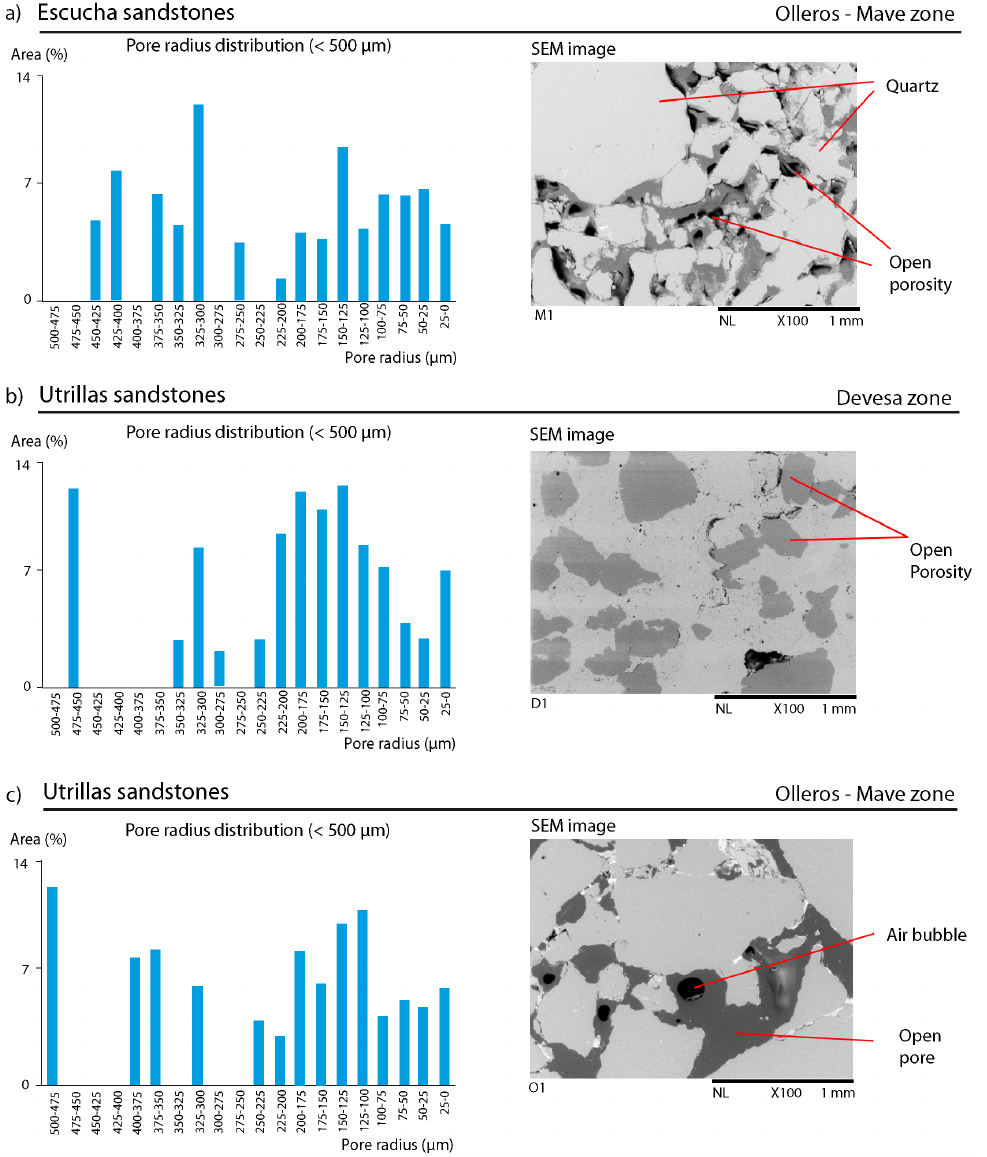
Figure 6. Pore size (radius) distribution histograms obtained by means of OIA-SEM ( a ) Escucha sandstones (Mave site); ( b ) Utrillas sandstones (Devesa site); ( c ) Utrillas sandstones (Olleros site). SEM images were obtained on samples impregnated with an epoxy resin in order to differentiate between open pores (dark grey) and minerals (light grey). Both closed pores and air bubbles resulting from imperfect impregnation appear in black color, which was taken into account and manually corrected during the digital image processing.